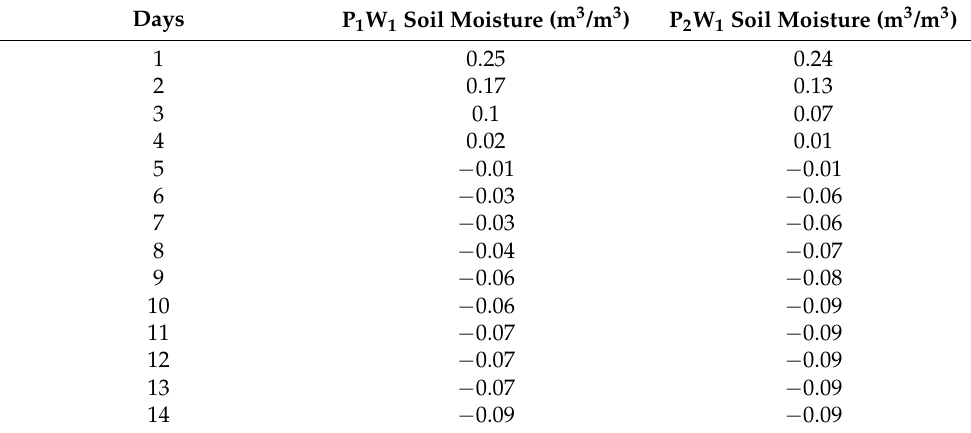
Table 15. Means (pooled) of soil moisture content (m 3 /m 3 ) in potted soil of pod-seeded common bean plants during a 14-day terminal drought stress period under phosphorus–water treatment in a